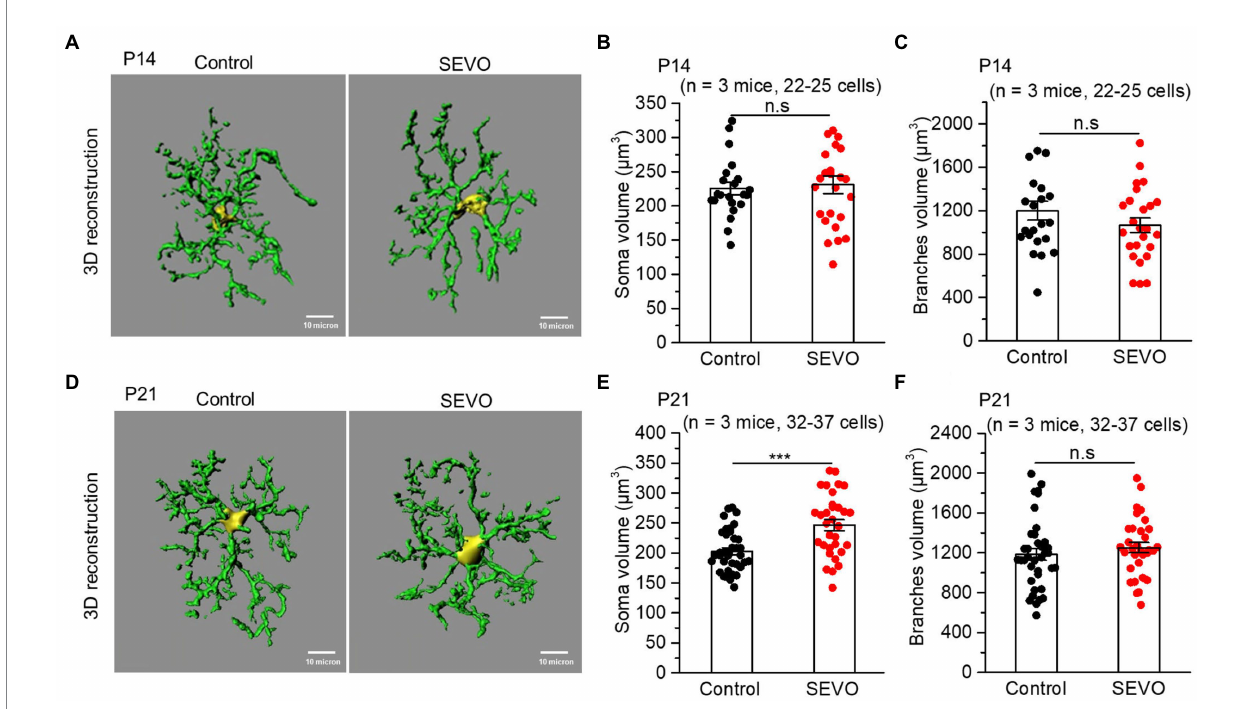
FIGURE 3 Three-dimensional morphology of microglia after prolonged neonatal sevoflurane exposure. (A) Representative images of IBA1-labeled microglia 3D reconstructed by Imaris software in the control and SEVO group 7 days after prolonged sevoflurane exposure. Yellow represents the cell body, and green represents branches. (B) Quantification of microglia soma volume 7 days after prolonged neonatal sevoflurane exposure ( p = 0.738, two-sample t -test). (C) Quantification of microglia branches volume 7 days after prolonged neonatal sevoflurane exposure ( p = 0.229, two-sample t -test). (D) Representative images of IBA1-labeled microglia 3D reconstructed by Imaris software in the control and SEVO group 14 days after prolonged sevoflurane exposure. Yellow represents the cell body, and green represents branches. (E) Quantification of microglia soma volume 14 days after prolonged neonatal sevoflurane exposure ( p < 0.001, two-sample t -test). (F) Quantification of microglia branches volume 14 days after prolonged neonatal sevoflurane exposure ( p = 0.399, two-sample t -test). Data are shown as mean ±